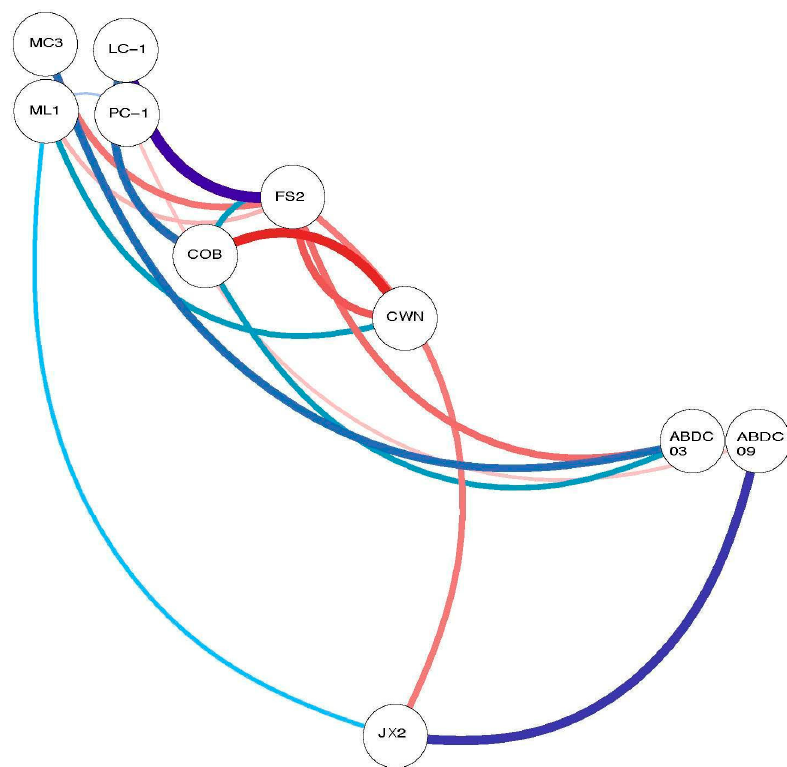
Figure 7. Network plot for deglacial speleothem records included in SISAL_v1 shown at zero temporal lag with sites arranged geographically. Correlation (gXCF) strength increases with width of line and depth of color. Blue lines represent positive correlations and red lines represent negative ones. These relationships are computed over the amount of time that each pair of records overlaps, so each relationship covers a slightly different temporal interval within the 10–22 ka window. Only correlations that fall outside of the 5 and 95% quantiles drawn from 2000 replicate surrogate testing plotted. Pairwise gXCF values are shown in Table 2. Records shown are from Abaco Island (ABDC), Cave of the Bells (COB), Cave without a Name (CWN), Fort Stanton Cave (FS2), Juxtlahuaca cave (JX2), Leviathan Cave (LC), Moaning Cave (MC), McLean’s Cave (ML), and Pinnacle Cave (PC).